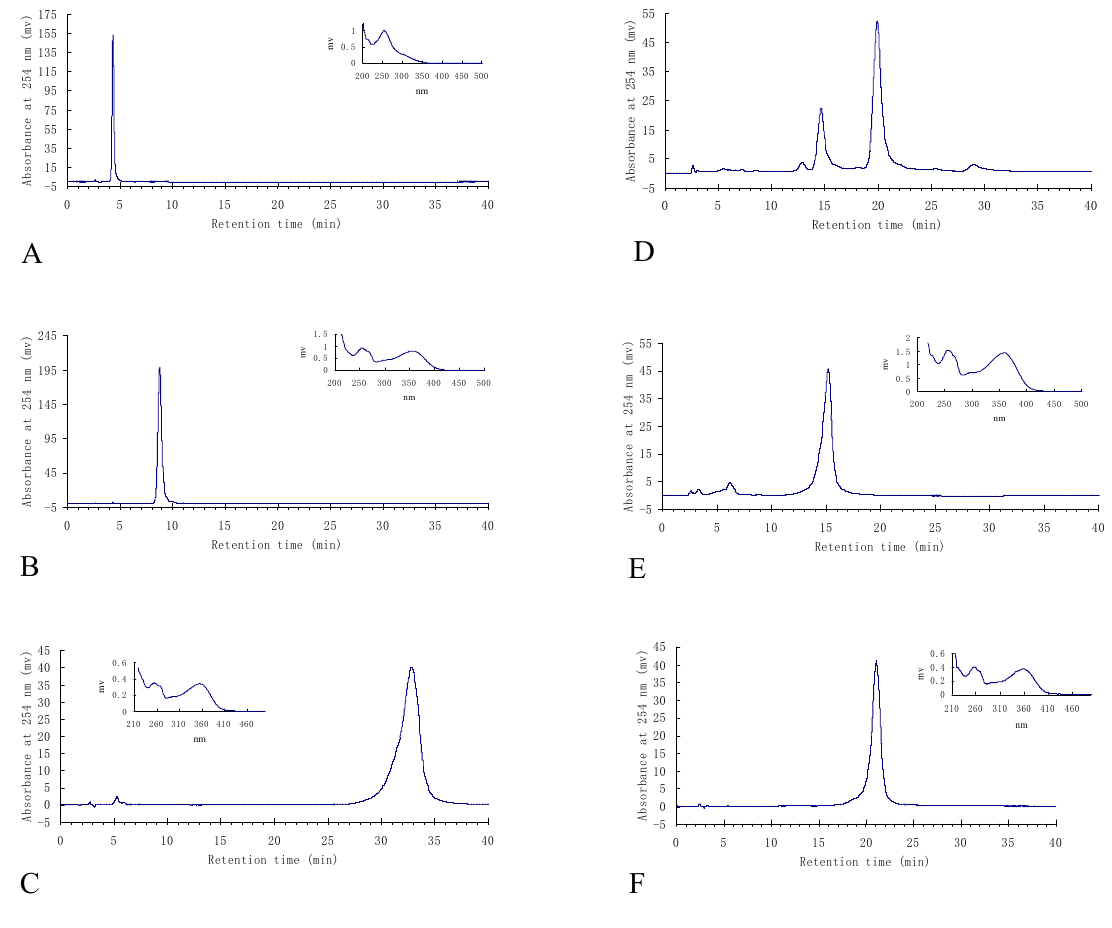
Figure 3. HPLC analyses and UV spectra of the HSCCC fractions. A: p -hydroxybenzoic acid ( 1 ) from HSCCC peak fraction 5; B: isorhamnetin-3- O - β -D-rutinoside ( 2 ) from HSCCC peak fraction 6; C: 3,3'-di- O -methylquercetin ( 5 ) from HSCCC peak fraction 3; D: the mixture of quercetin ( 3 ) and 3- O -methylquercetin ( 4 ) from HSCCC peak fraction 2; E: quercetin ( 3 ) separated from the above mixture by preparative HPLC; F: 3- O - methylquercetin ( 4 ) separated from the above mixture by preparative